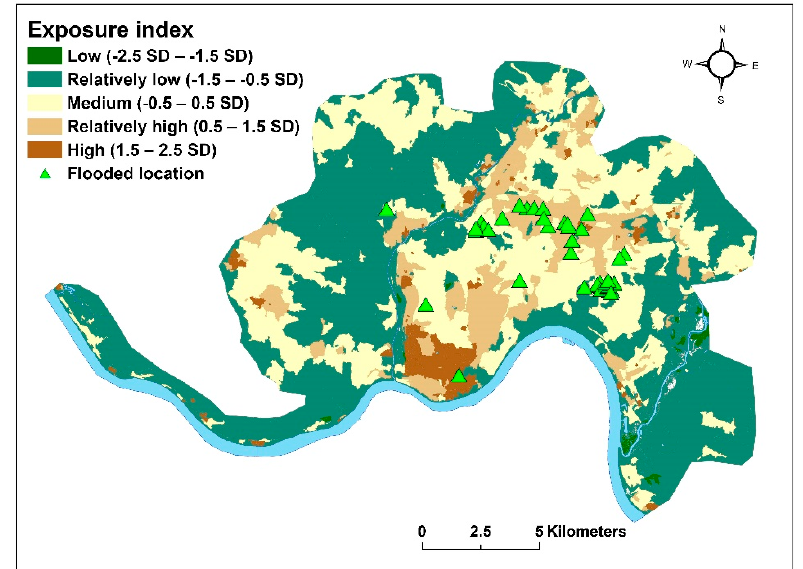
Figure 4. Exposure index. Figure 4. Exposure Table 2. Summary of exposure index (EI) of flooded locations based on EI level.